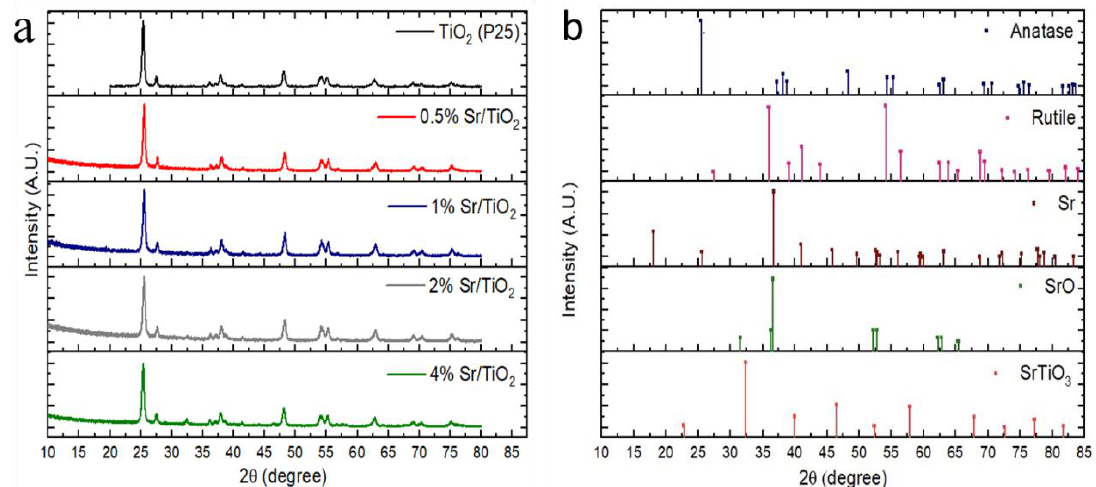
Figure 2. ( a ) XRD patterns of pristine TiO 2 and Sr-doped TiO 2 photocatalysts compared with ( b ) JCPDS reference patterns of anatase, rutile, Sr, SrO, and SrTiO 3 .